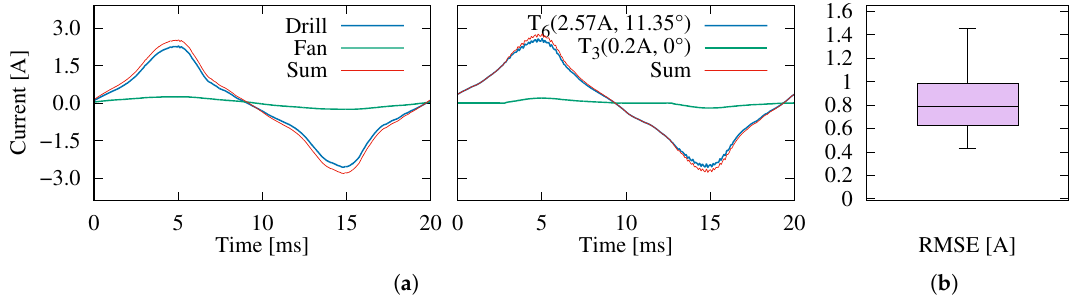
Figure 14. Results of the complete optimization approach to approximate the superimposed current waveforms of a drill and a fan appliance by means of parametric templates. ( a ) Aggregation of input data from the same two electrical appliances as before, as well as a visualization of their reconstruction from templates; ( b ) Distribution of RMSE